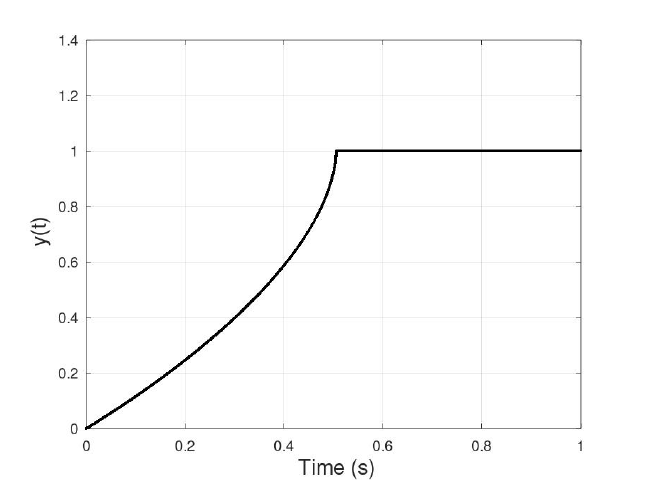
Figure 6. Solution from NSM for a =